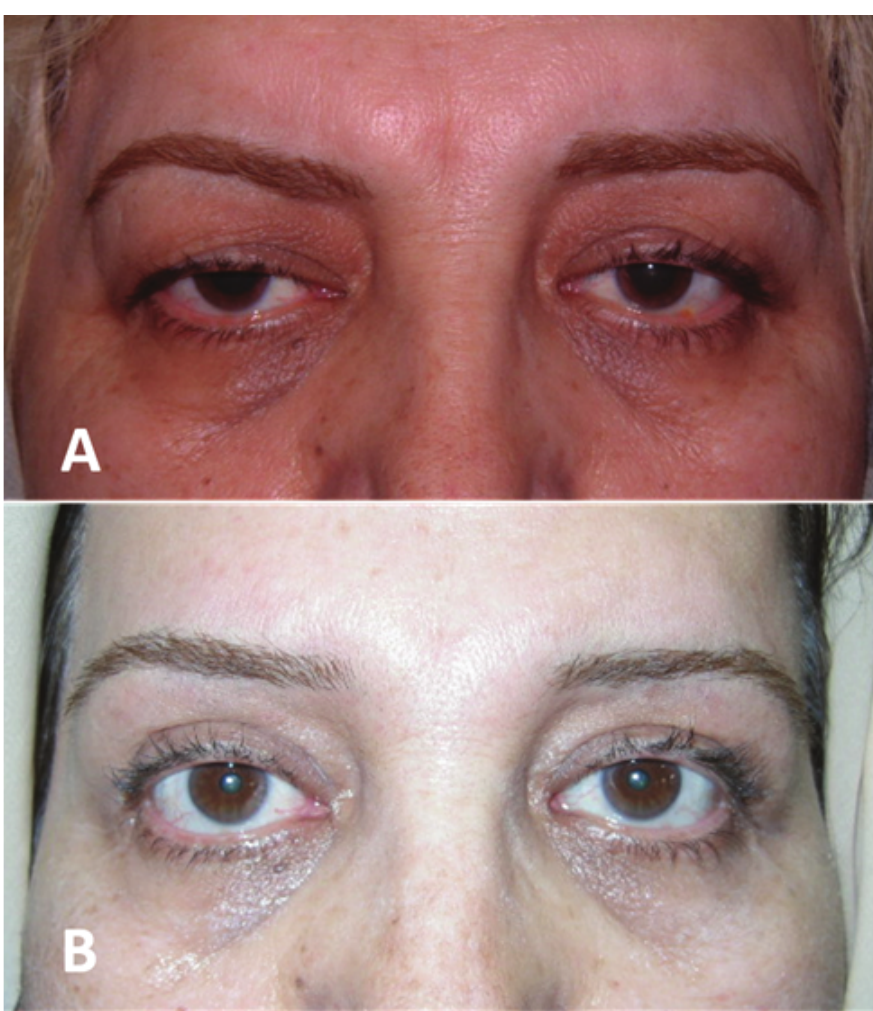
Figure 8. Before (A) and after (B) transcoronal lift with upper blepharoplasty and ptosis repair.